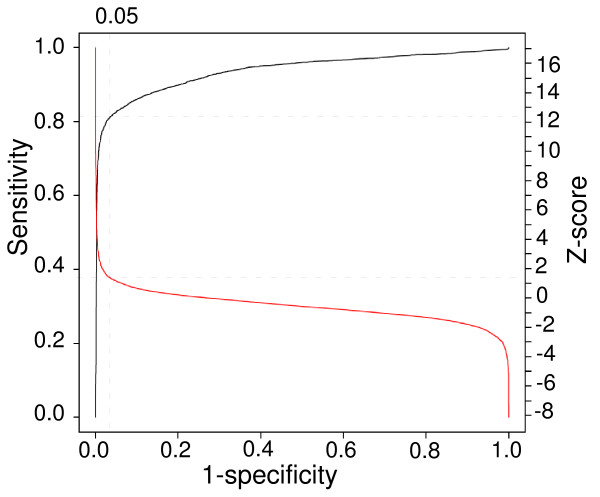
Relationship of receiver operating characteristic (ROC) curve and Z-score values and estimates of SFP call rates. The black line is the ROC curve, and the red line is the Z-score curve. The vertical dash line indicates false positive rate (1-specificity) of 5%, and horizon lines point to a Z-score value of 1.5 and sensitivity level (call rate) of approximately 81%, respectively. The curves were generated using data from all replicates of hybridization. SFP calls were compared with known NIAID SNP described previously (see text).